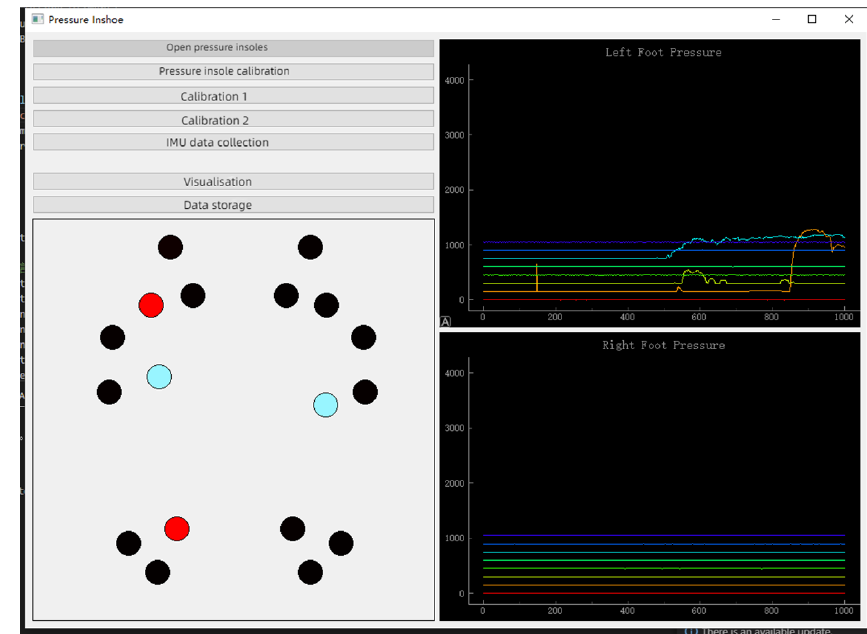
Figure 2. Acquisition interface diagram.